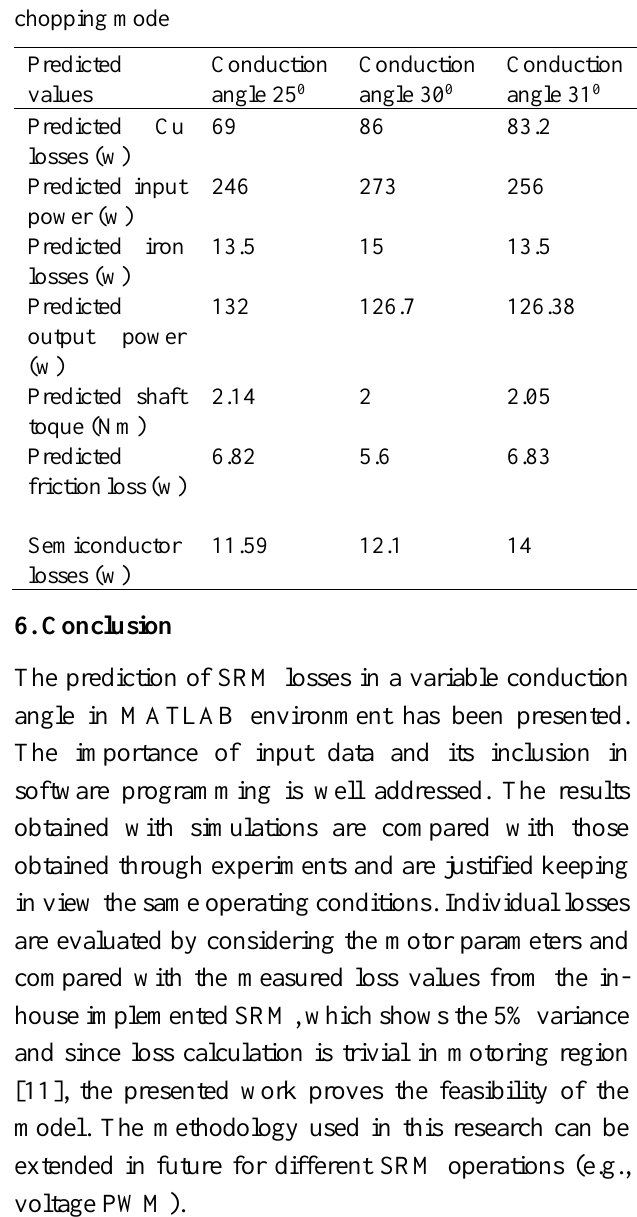
Fig. 15. Losses at different conduction angles in current chopping